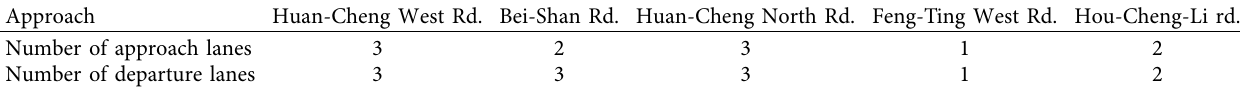
Table 1: Te number of lanes on each leg.